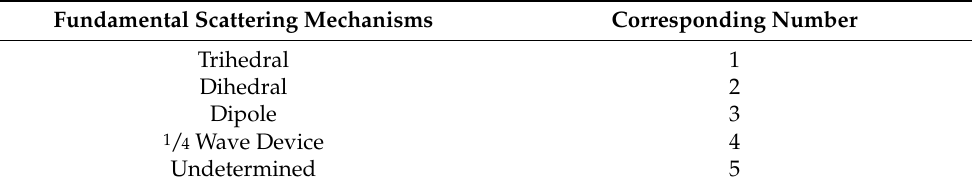
Table 2. Scattering mechanisms according to Double Scatterer Model.